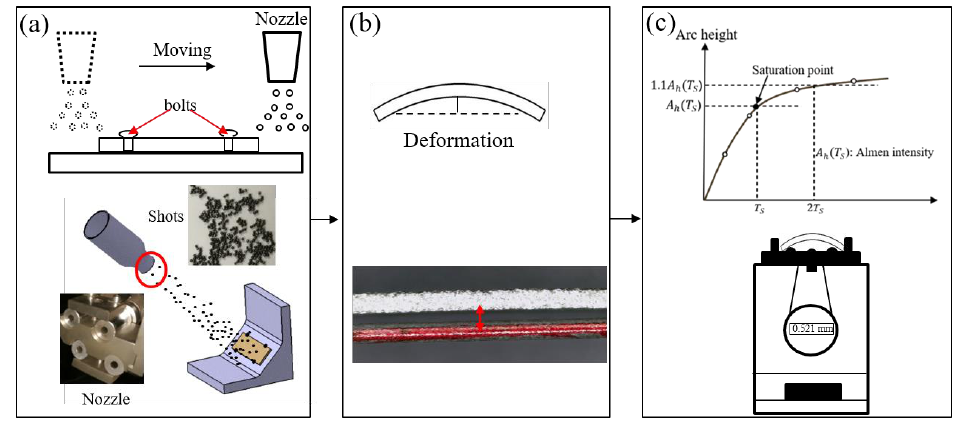
Figure 1. Almen intensity test process. ( a ) The strips are fixed on their holders. ( b ) After a certain amount of coverage, the strips are removed from the holders. The strips bend and extend. ( c ) This arc height is measured by the Almen gauge and Almen intensity is obtained by saturation curve.